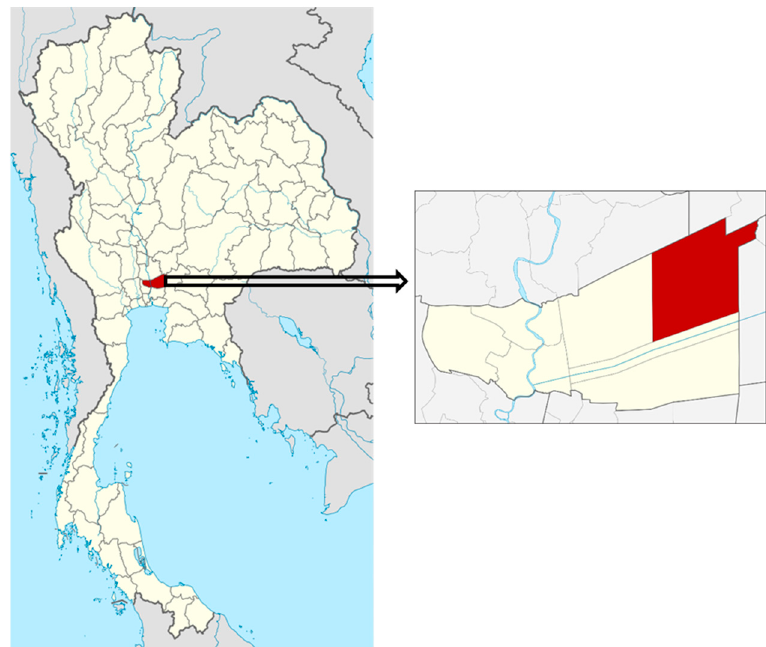
Figure 1. Study site [27,28]